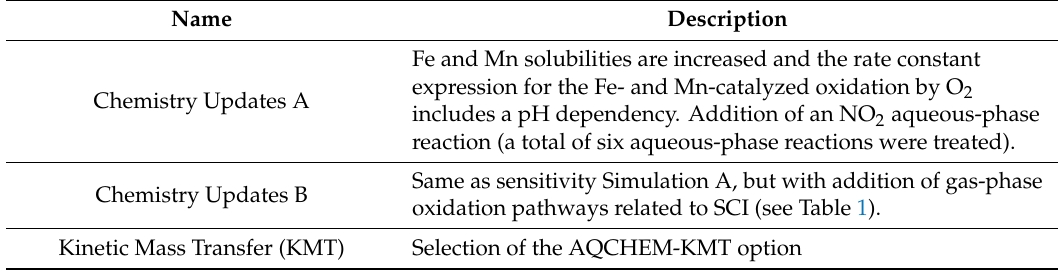
Table 2. Summary of Community Multiscale Air Quality (CMAQ) simulations conducted in this study.